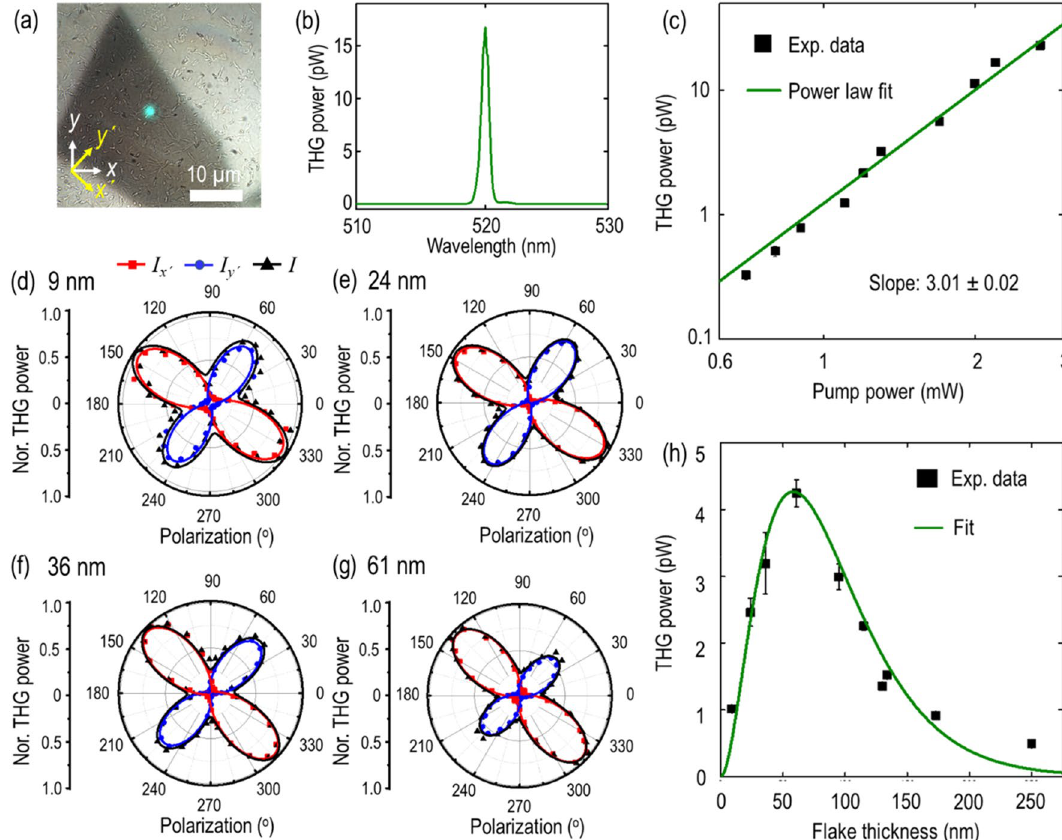
Figure 5. ( a ) Optical transmission microscope image of the 61 nm-thick teallite crystal with green THG emission. x - and y -axes indicate the crystalline b - and a -axes, whereas x ′ - and y ′ - axes denote the optical axis of the probed crystal and its perpendicular direction. ( b ) Recorded THG emission spectrum. ( c ) Log-scale plot between THG emission power and pump power. ( d – g ) Polarization-resolved THG emission power for four different teallite flakes with thicknesses of 9, 24, 36, and 61 nm. Red squares, blue dots and black triangles denote the measured data points along x ′ -component ( I x ′ ), y ′ -component ( I y ′ ), and total ( I ) THG emission power, respectively, while the theoretical fits are specified in the respective colors. ( h ) Thickness-dependent THG emission power. The measured THG emission power in ( c ) and ( h ) are shown with black squares, whereas the theoretical fits are indicated with solid green